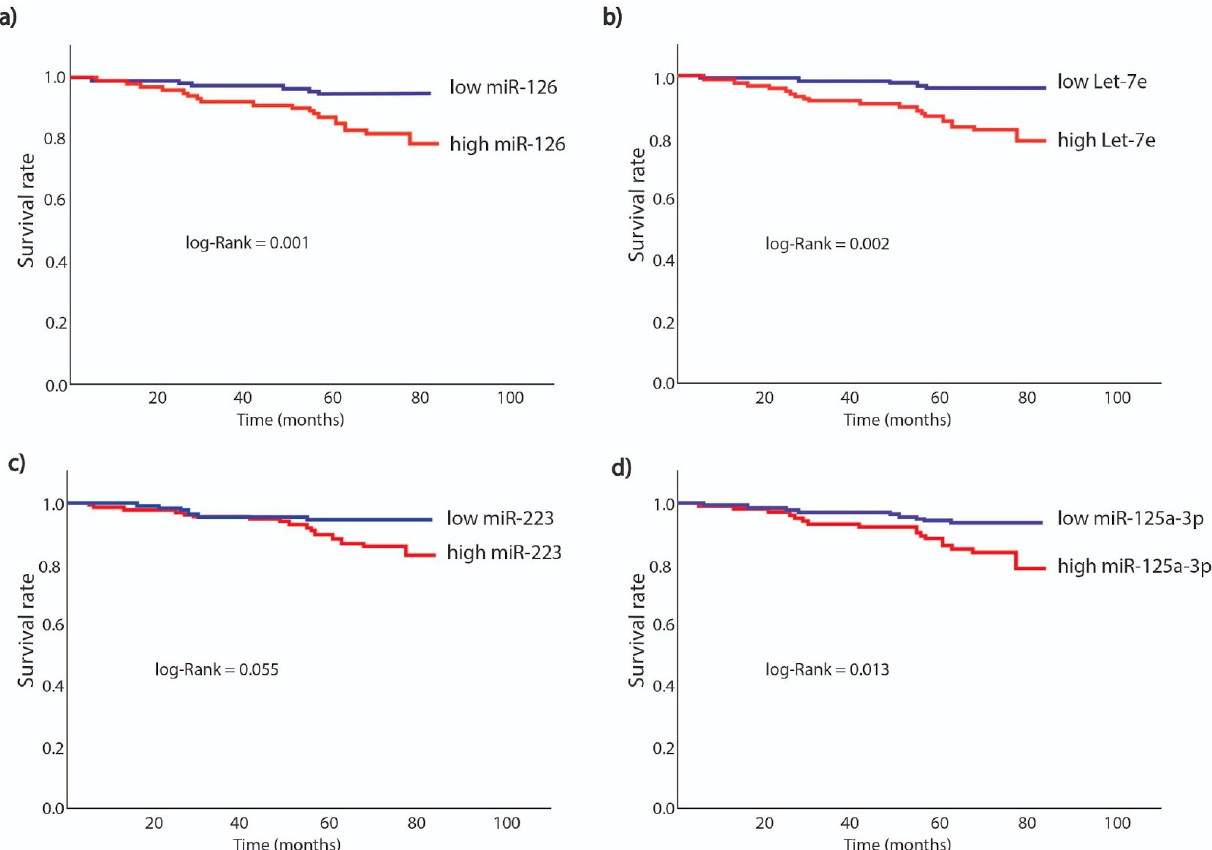
Figure 5. Kaplan–Meier survival analysis for all-cause death. HR are adjusted for clinical variables in a multivariate model with a single miRNA as a covariate ( a ) high vs. low miR-126; ( b ) high vs. low Let-7e; ( c ) high vs. low miR-223; ( d ) high vs. low miR-125a-3p. Table 3. Univariate and multivariate Cox regression model for prediction of long-term all-cause of